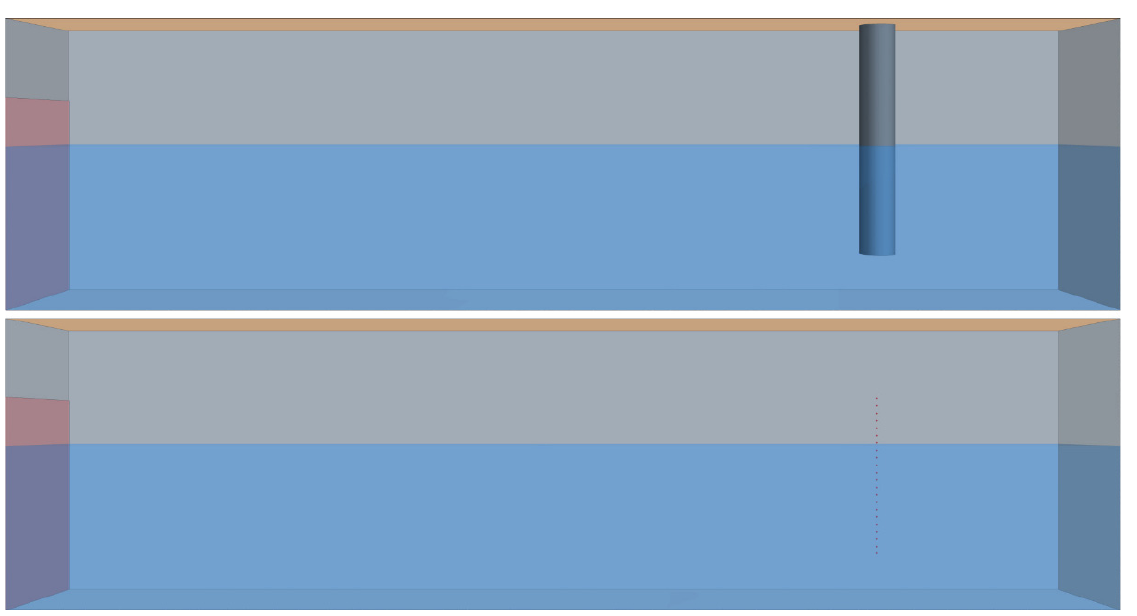
Figure 8. Arrangement of a single cylinder in the first scenario ( top ) and the 210 probe points (only 22